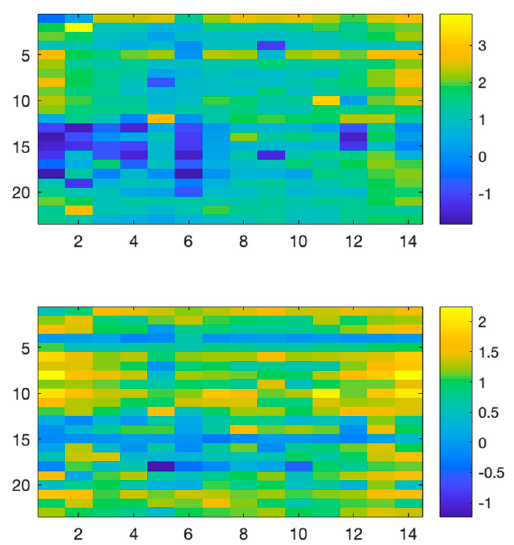
Figure 1. Features vector for offset (upper panel) and exponent (lower panel) computed for a single video clip extracted from the DREAMER dataset. Rows represent subjects and columns represent electroencephalogram (EEG) channels.